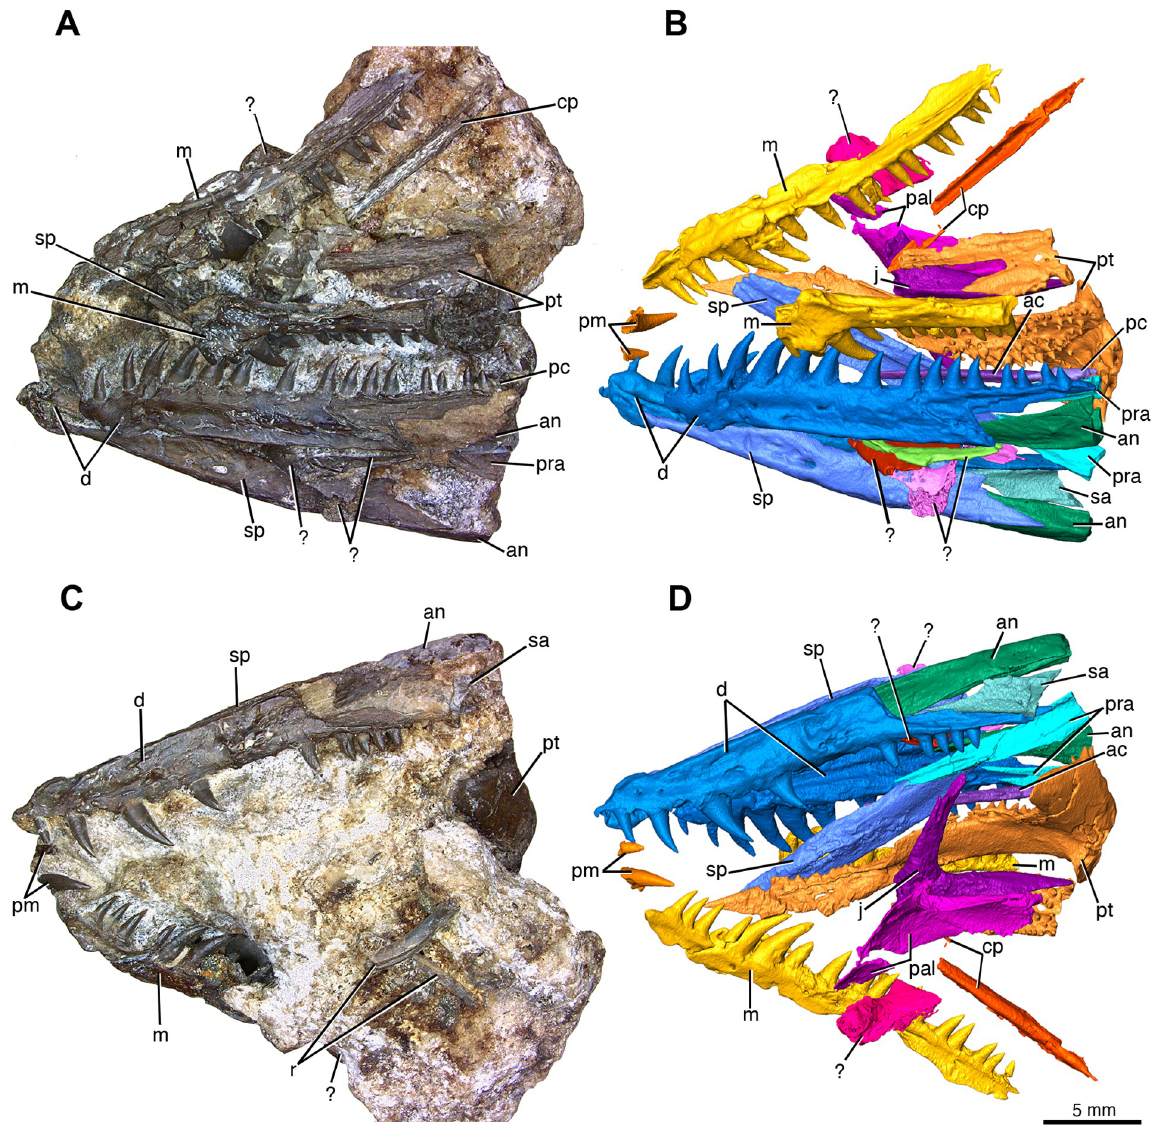
Fig 1. Partial skull of Maiothisavros dianeae (ROMVP 87366) and corresponding renderings based on CT imaging sequences. (A) left lateral view and (C) right lateral view of Maiothisavros dianeae ROMVP87366 specimen photo. (B) left lateral and (D) right lateral three- dimensional model of Maiothisavros dianeae from CT image sequences. Abbreviation: an, angular; ac, anterior coronoid; cp, cultriform process; d, dentary; j, jugal; m, maxilla; pal, palatine; pc, posterior coronoid; pm, premaxilla; pra, prearticular; pt, pterygoid; r, rib; sa, surangular; sp, splenial;?, unknown